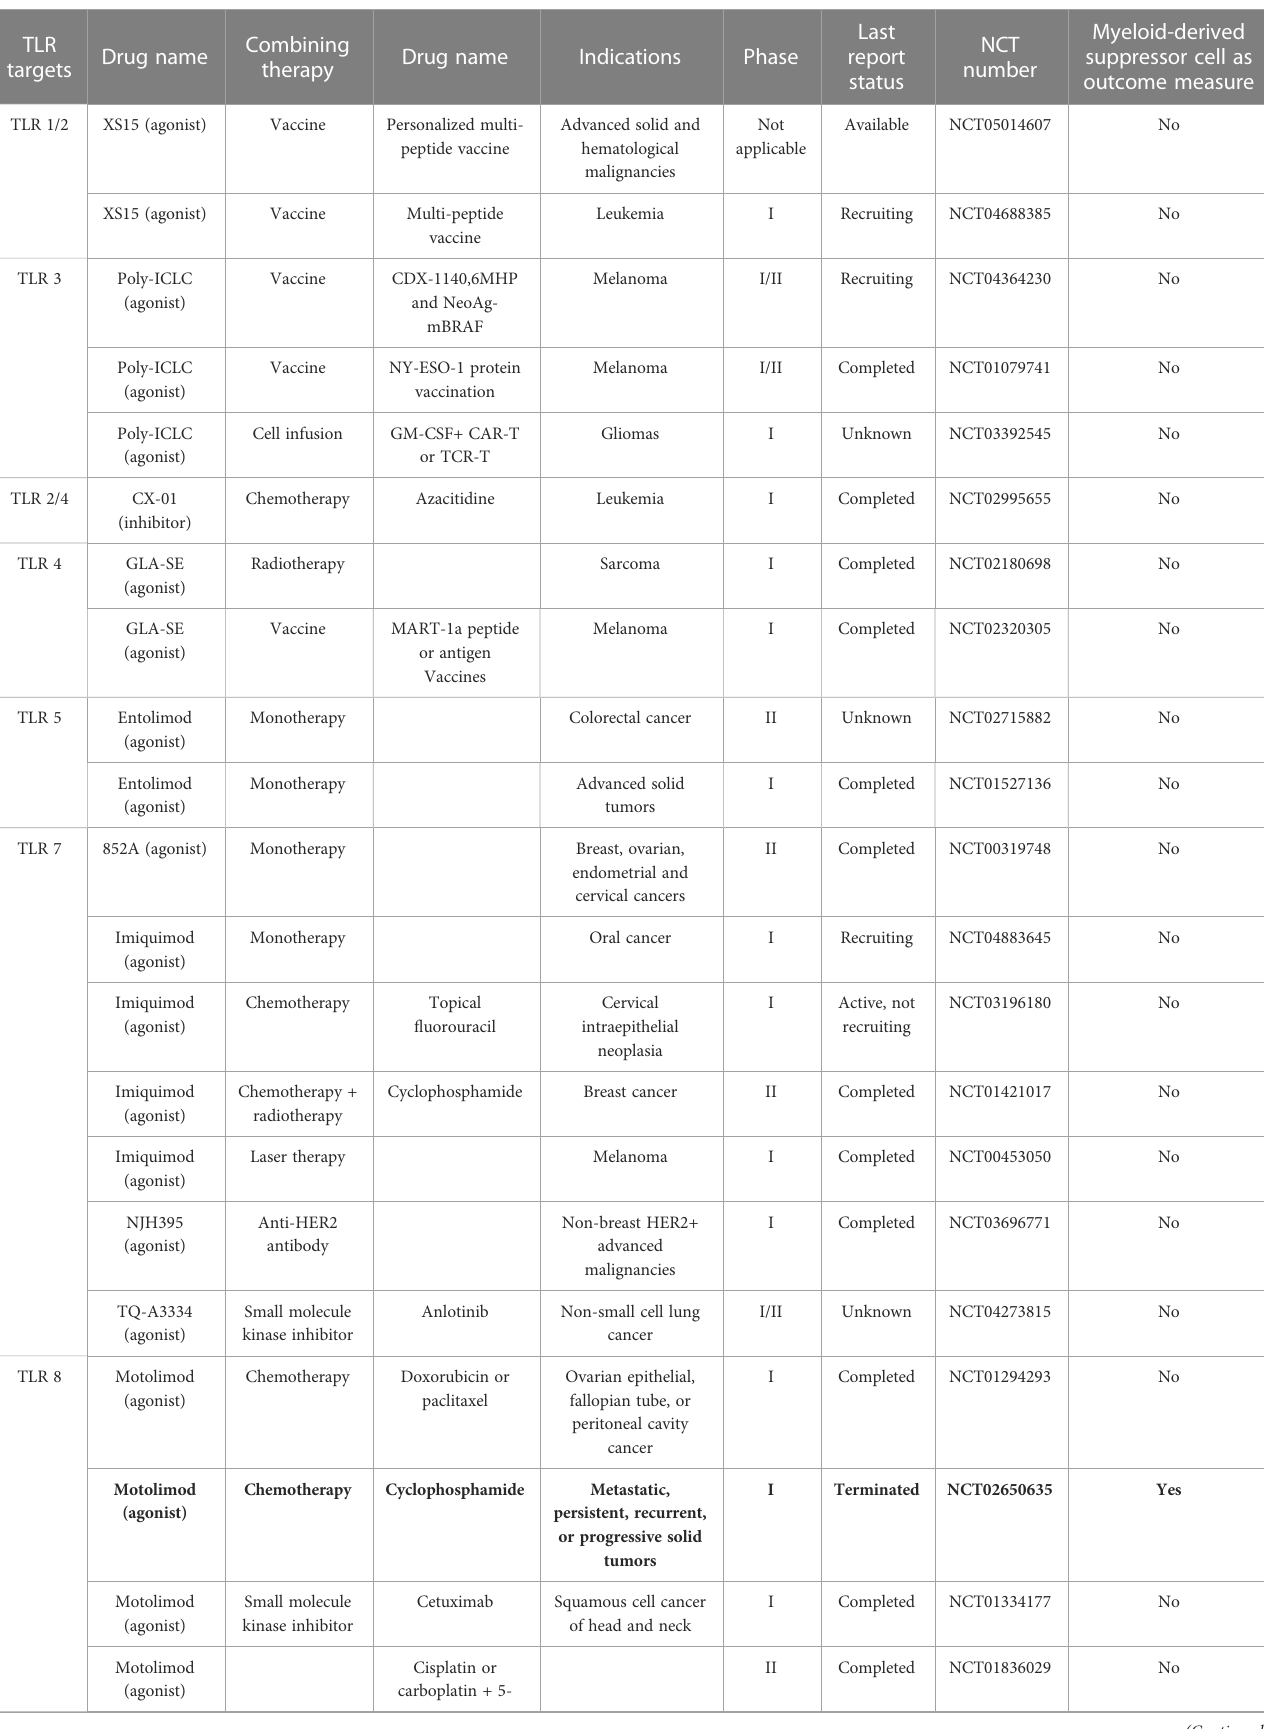
TABLE 2 Summary of clinical trials targeting Toll-like receptor (TLRs) as monotherapy or in combination with other treatments.